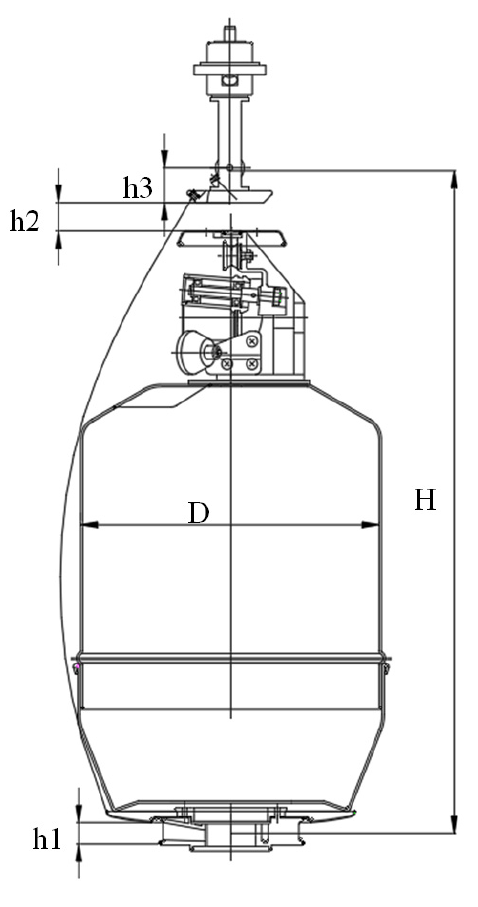
Figure 3. Schematic diagram of direct-twisting mechanism.